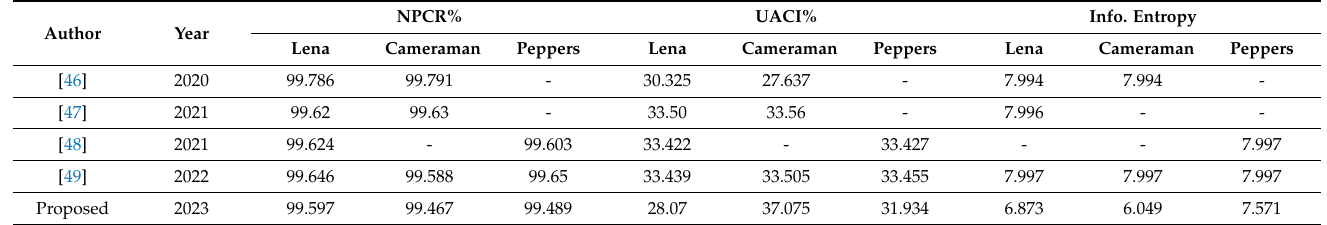
Table 5. NPCR and UACI comparison between proposed scheme and other algorithms.